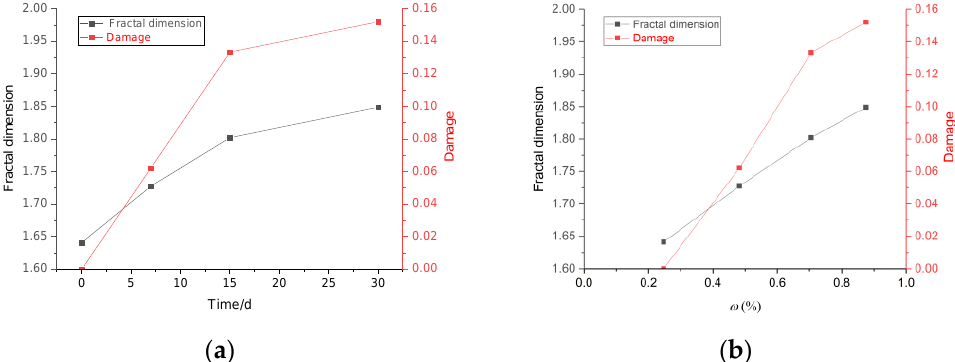
Figure 7. ( a ) The relationship between the fractal dimension/degree of damage and the water immersion time. ( b ) The relationship between the fractal dimension/degree of damage and the water